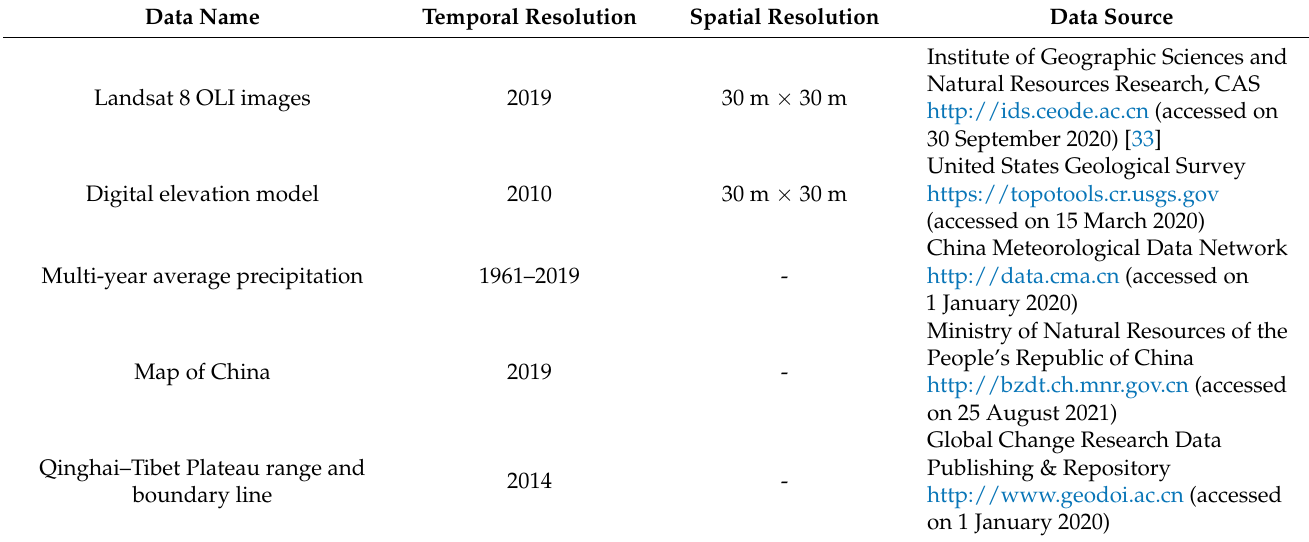
Table 2. Statistics of Highland barley planting areas in various agricultural